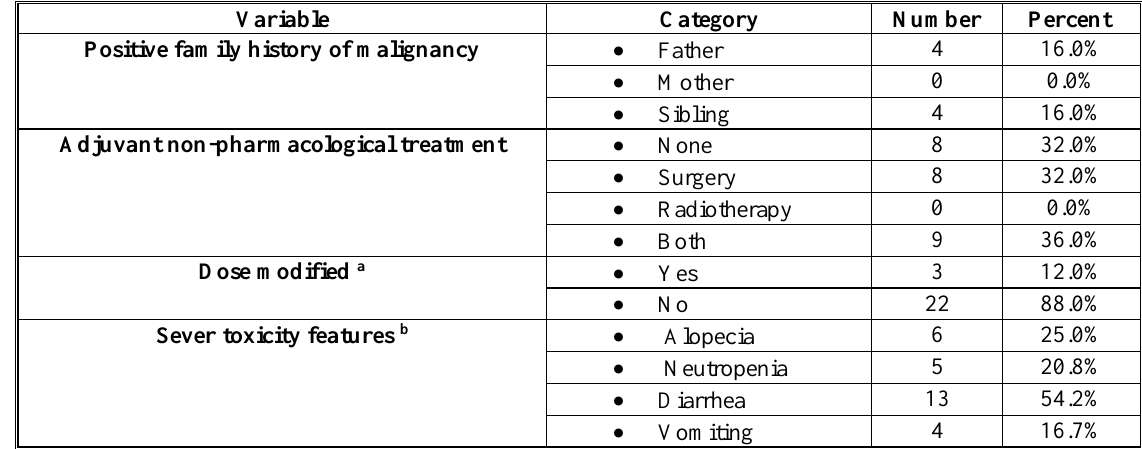
Table 3. Clinical characteristics of patients.